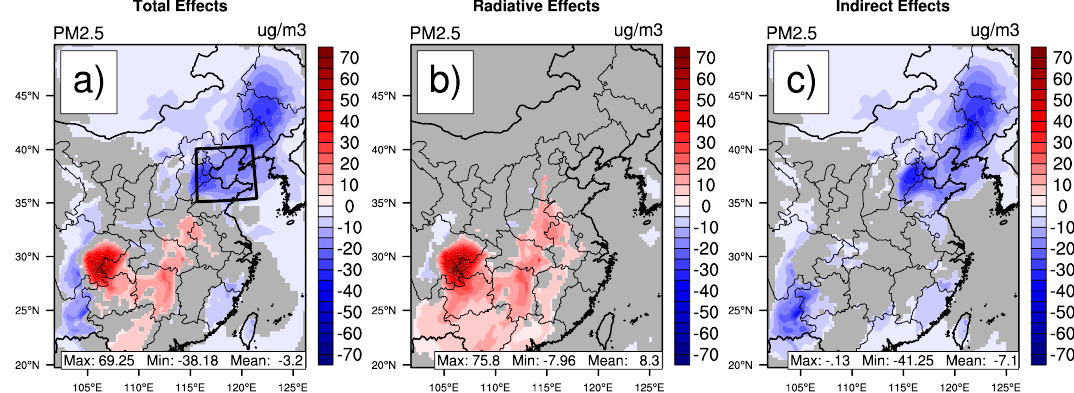
Figure 10. Simulated aerosol total effects (BASE − EMP), radiative effects (RAD − EMP), and indirect effects (BASE − RAD) on monthly mean PM 2 . 5 over eastern China in January 2013. Grey shaded areas indicate regions with less than 95% significance. The black polygon defines the Bohai Sea’s surrounding area.